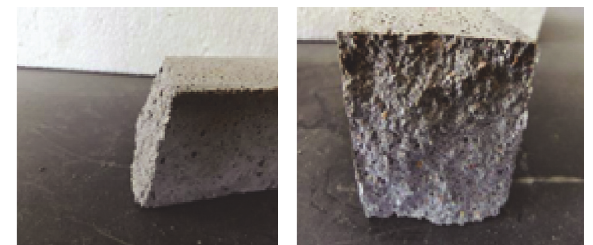
Figure 6: Reference mortar flexural failure mode.